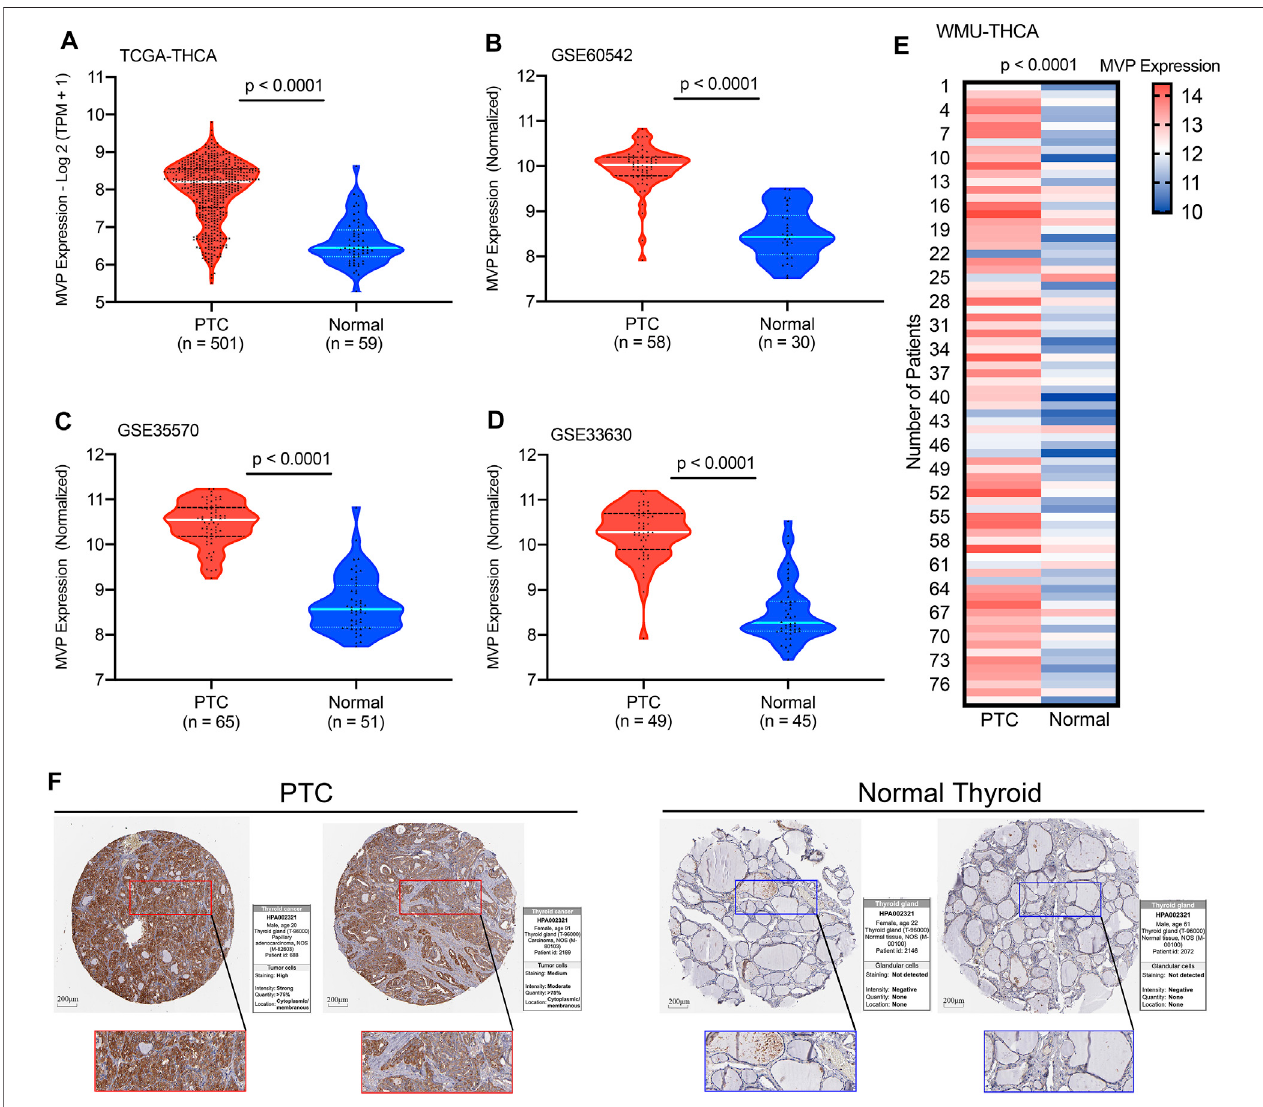
FIGURE 1 | MVP expression levels in PTC and normal thyroid tissues. The MVP mRNA expression in PTC and ANT obtained from the (A) TCGA-THCA, (B) GSE60542, (C) GSE35570, and (D) GSE33630 datasets. (E) MVP expression in local WMU-PTC samples and matched ANT by RNA-Seq. (F) Representative IHC images and detailed MVP pro fi les in malignant tissues and ANT were acquired from THPA database.